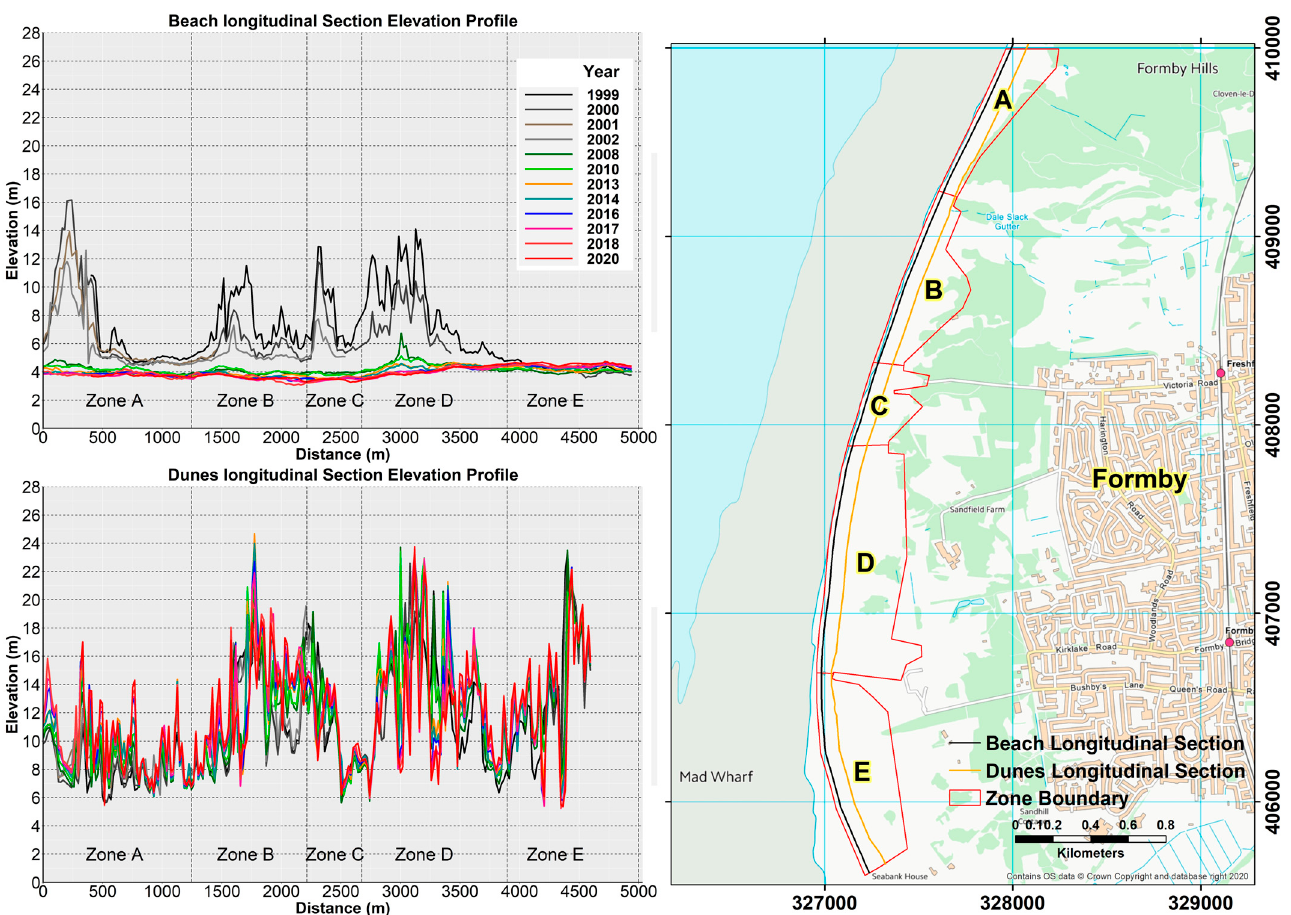
Figure 8. Beach and dunes longitudinal elevation profiles. The black line on the map figure shows the location of the beach longitudinal profile. The orange line shows the location of the longitudinal profile over the dunes. Most of the elevation changes on the beach longitudinal profile occurred between 1999 and 2008. The irregularity of the dunes longitudinal elevation profile illustrates the dune’s topographical complexity.